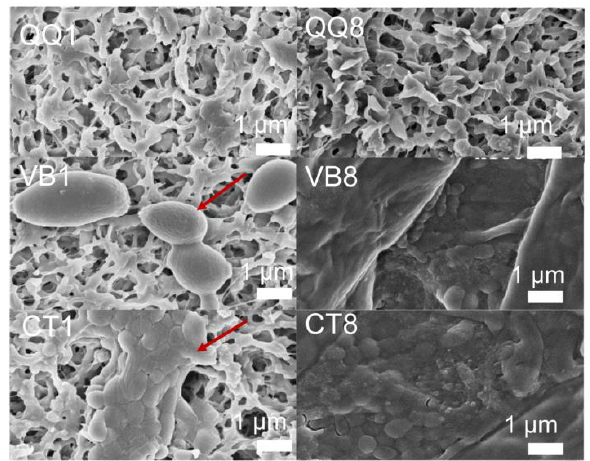
Figure 3. HG10 beads hindered biofouling on PVDF membranes. Scanning electron microscopy (SEM) images of PVDF membrane surfaces with quorum quenching (QQ) beads, vacant beads (VB), or the control without beads (CT): Left column, after 1 day incubation; right column, after 8 day incubation (magnification factor, 10,000 ×